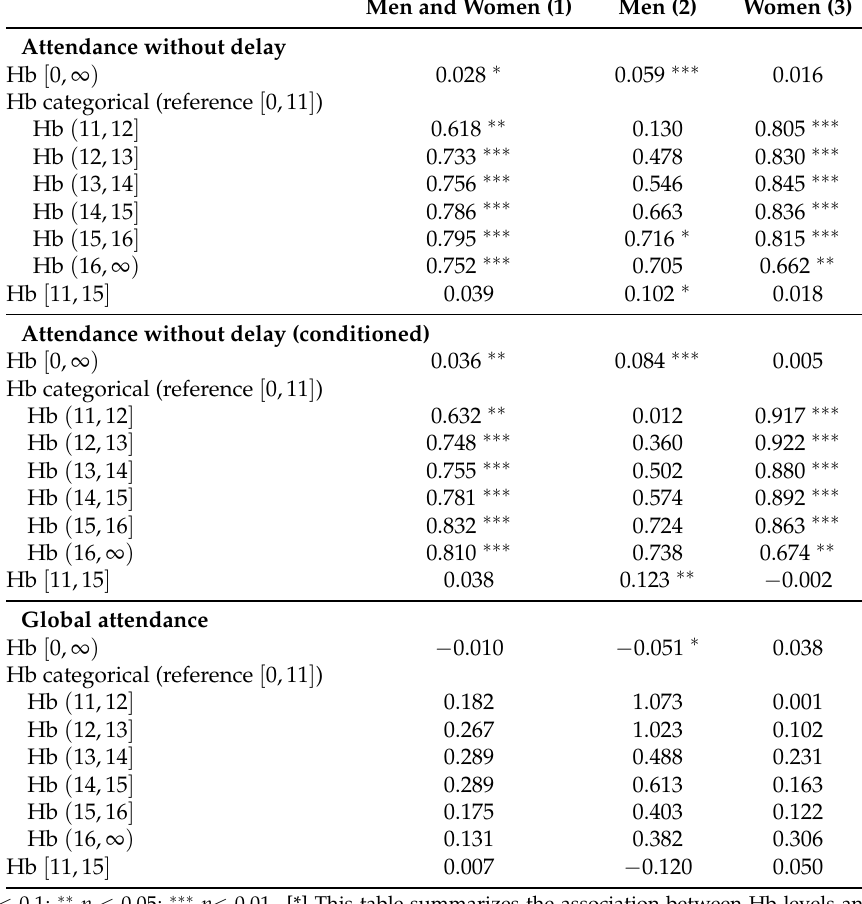
Table A6. Estimation of several alternative